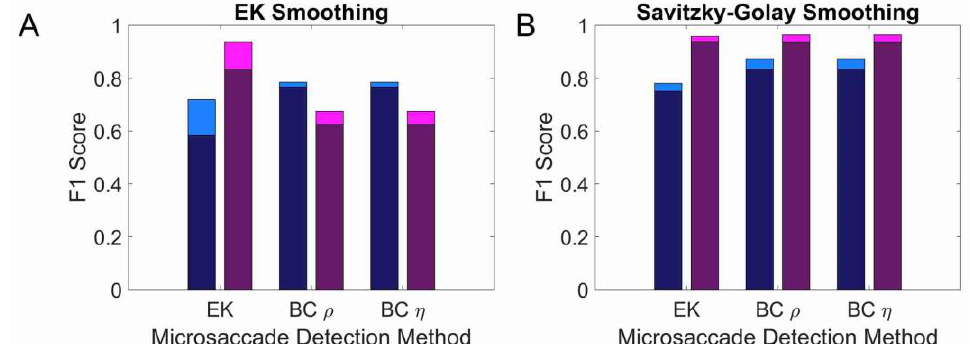
Figure 6: Transferability of the different detection methods between datasets. The deeply coloured section of each bar indi- cates performance when transferring the optimal parameters for one of the two datasets to the other, while the lightly col- oured section of each bar indicates the added benefit from using the optimal parameters for each dataset. Results for the Ox- ford dataset are given in blue, while the results for the Lund dataset are given in purple. Panel A shows the transferability using data smoothed with a Savitzky-Golay filter and panel B shows data smoothed using the EK filter.